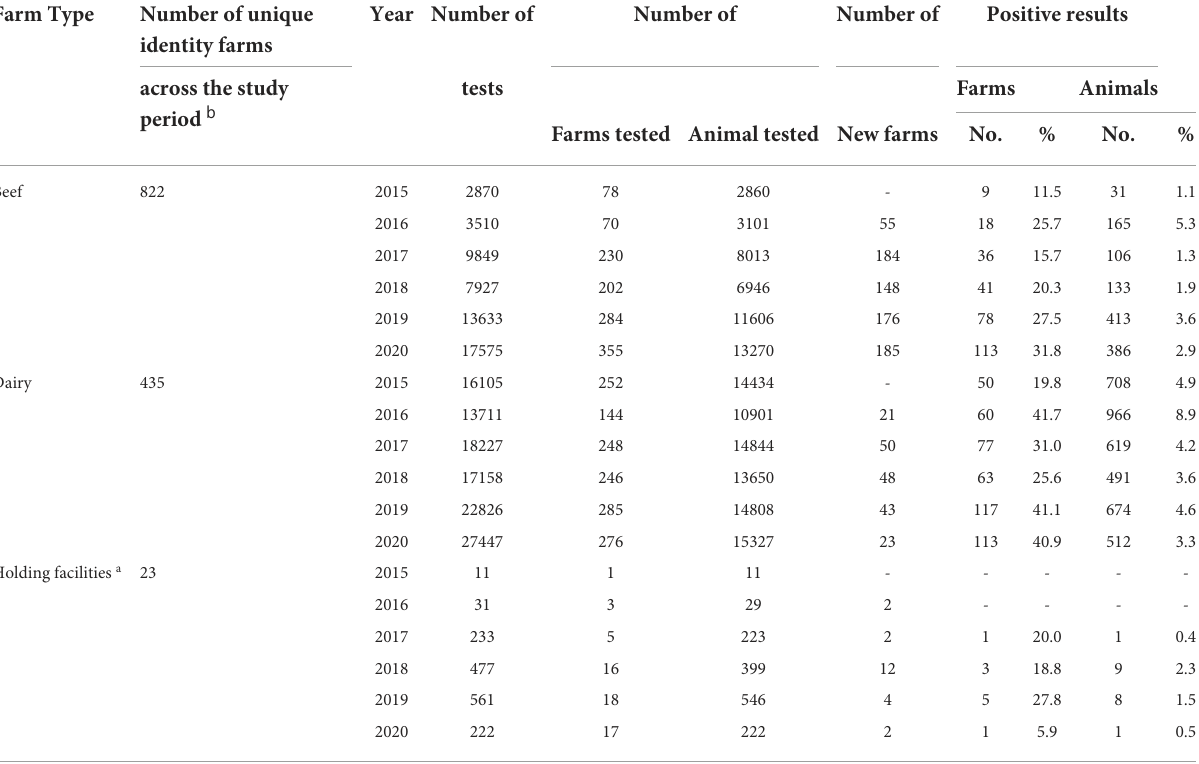
TABLE 4 Beef farms, dairy farms and holding facilities: Number of tests, number of farms and animals tested for bTB by the Fiji BTEC program from 2015 to 2020. Farm Type Number of unique Year Number of Number of Number of Positive results identity farms across the study tests Farms Animals period b Farms tested Animal tested New